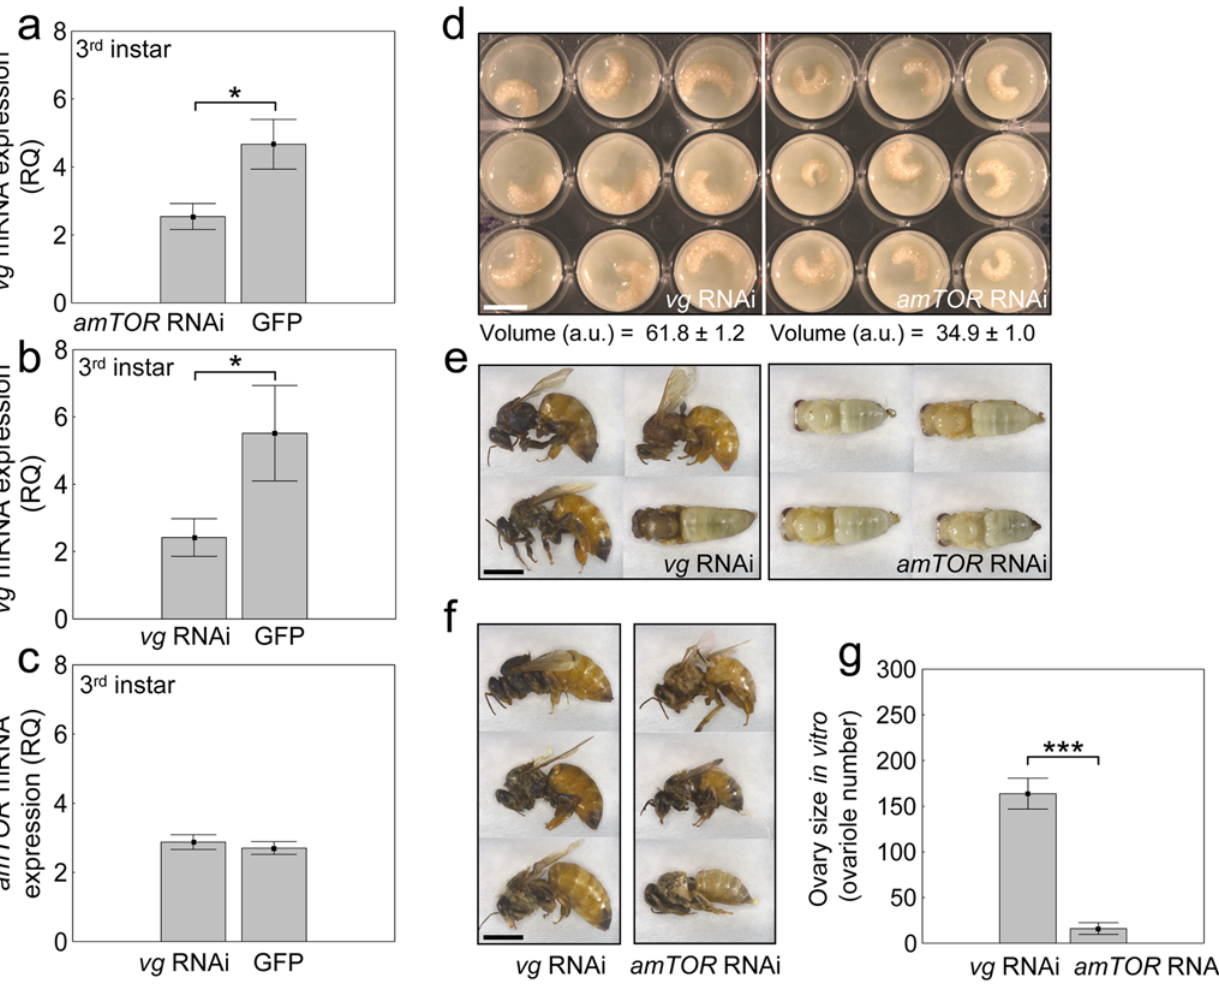
Figure 4. Control experiment comparing amTOR suppression (amTOR RNAi) with vitellogenin suppression (vg RNAi). In 3 rd instar larvae, vitellogenin mRNA a, was reduced by amTOR RNAi. Yet when b, vitellogenin was similarly suppressed by vg RNAi, amTOR c, remained unaffected. Thus, vg RNAi is an unconfounded control for amTOR RNAi. In comparison to vg RNAi, amTOR RNAi: d, reduced larval growth (exemplified by 5-day-old larvae, larval volume is mean 6 s. e., arbitrary units); and delayed development (days until adult emergence: vg RNAi, 20.14 6 0.14; amTOR RNAi, 24.00 6 0.58) – also shown in e, a snapshot of phenotypic variance (20-day-olds), which demonstrates that vg RNAi bees had emerged with queen characters or had advanced pupal pigmentation; while amTOR RNAi bees were pupae, lightly pigmented and small. f, adult size of the last vg RNAi bees to emerge (21 st day) vs. TOR RNAi bees (adult wet-weight mg: vg RNAi, 197.14 6 7.94; amTOR RNAi 119.67 6 12.03). In comparison to vg RNAi, amTOR RNAi also reduced ovary size g, (range vg RNAi: 62–210; amTOR RNAi: 4–26 ovarioles/ovary, ANOVA: F 1,8 =118.92, P , 0.00001). These data accurately replicate our comparison of GFP controls and amTOR RNAi (Fig. 3). Bars are means 6 s. e. (asterisk P , 0.05). Scale bars d: 10 mm; e, f: 5 mm.